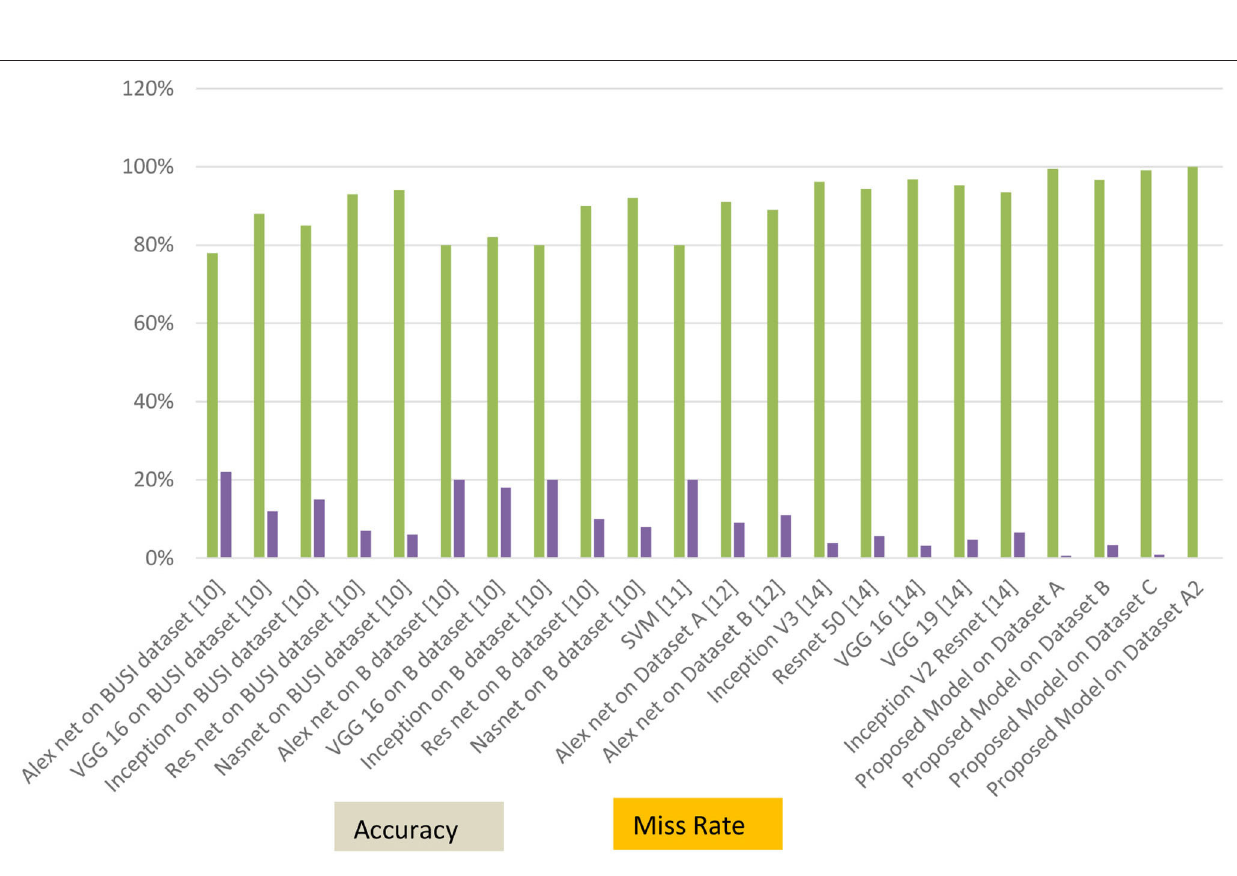
FIGURE 15 | Accuracy and miss rate in contrast with previous